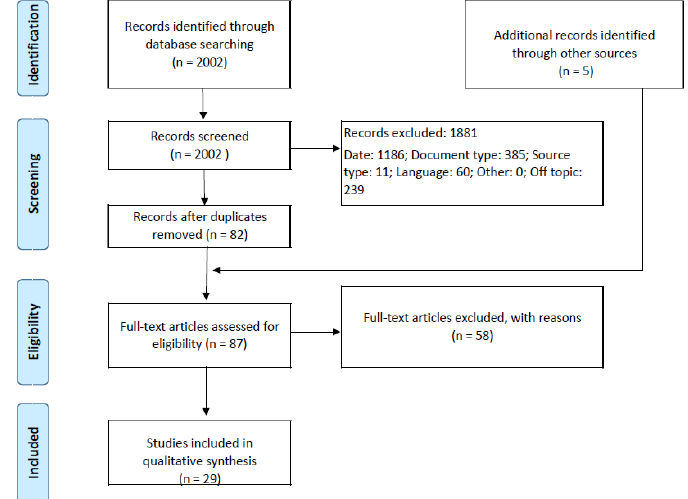
Figure 1. Research flow diagram.